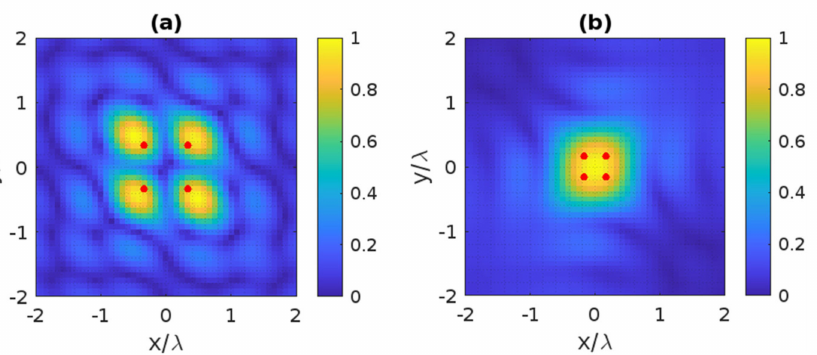
Figure 11. The reconstructed image of four point-like scatterers in the angle mode when their spacing equals ( a ) and is less ( b ) the resolution. The red dots indicate the position of the scatterer